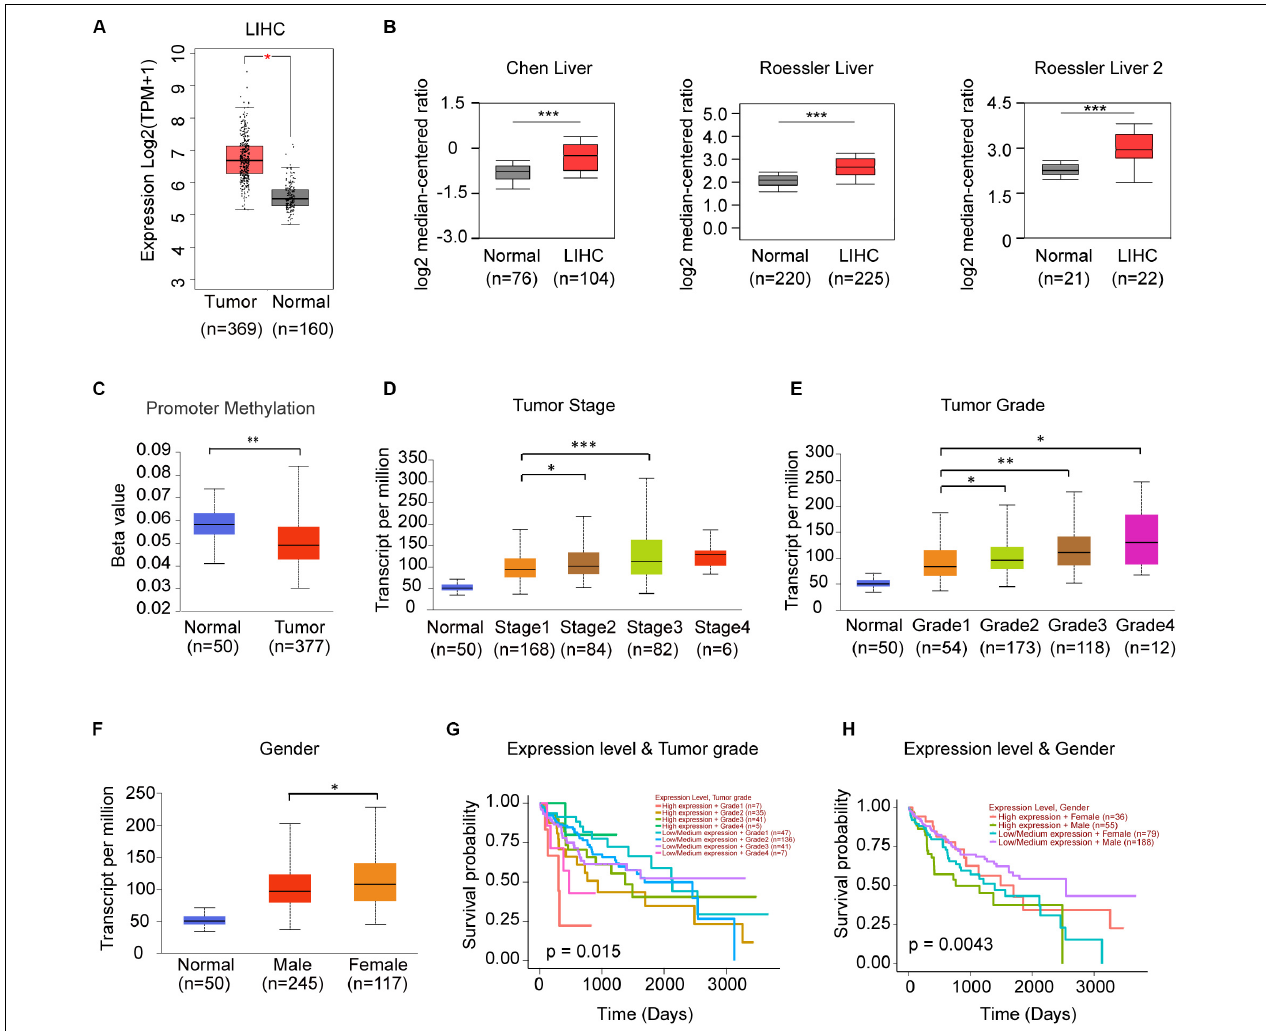
FIGURE 5 | PPP2R1A might serve as the oncogene in LIHC. (A) Comparison of the mRNA expression level of PPP2R1A between normal and tumor tissues in TCGA-LHC database using GEPIA. (B) The mRNA expression level of PPP2R1A in the studies of LIHC in Oncomine database. (C–F) Expression of PPP2R1A in LIHC based on promoter methylation level (C) , individual cancer stages (D) , tumor grade (E) , and gender (F) . The Beta value indicates level of DNA methylation, and 0 means unmethylated, and 1 means fully methylated. (G,H) Kaplan-Meier plot showing the significant difference of the effect between PPP2R1A expression level, and tumor grade (G) and gender (H) in LIHC patients, respectively. * p < 0.05, ** p < 0.01, *** p <